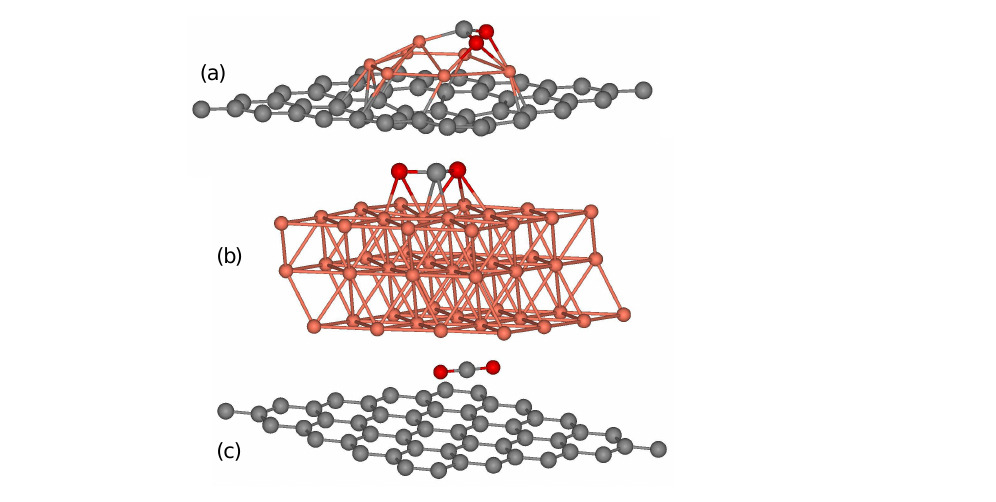
Figure 4. Schematic representation of the most energetically favorable adsorption positions of CO 2 molecule on ( a ) Cu 7 /graphene nanostructure, ( b ) Cu (111) surface, and ( c ) pristine graphene monolayer. Grey balls stand for carbon atoms, orange for copper, and red balls are